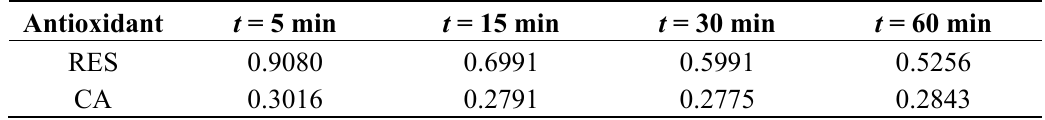
values in moles of antioxidant (resveratrol and caffeic acid) per mol of Table 1. EC 50 DPPH obtained at reaction times of 5, 15, 30 and 60